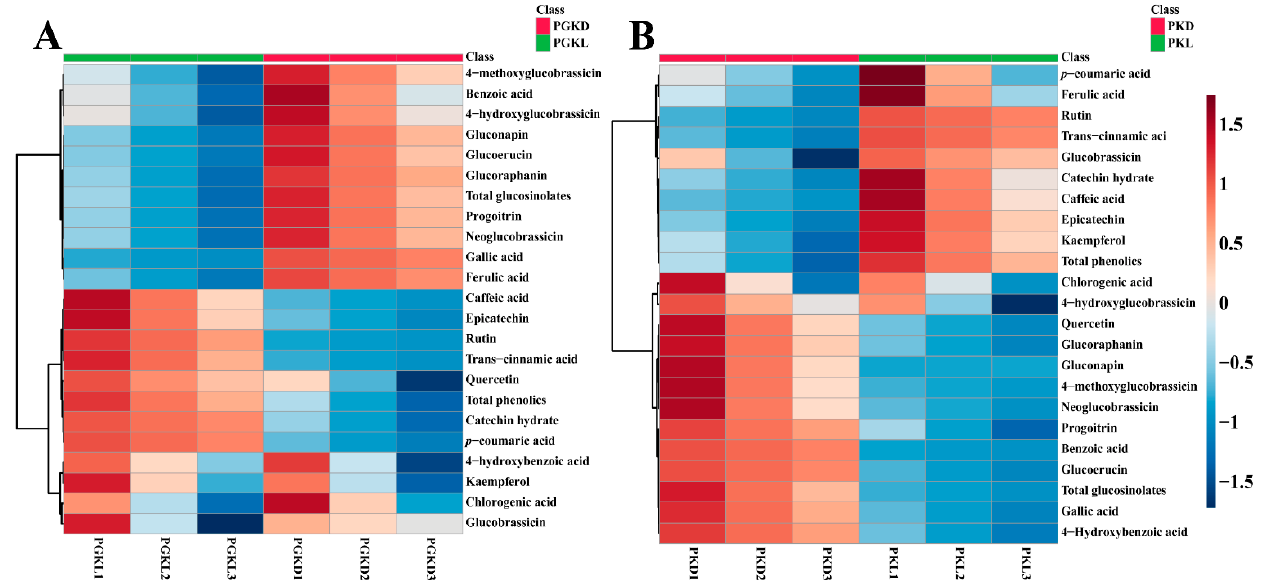
Figure 6. Heatmap ( A ) representing differences in the relative secondary metabolites concentration in the PGK cultivar grown under light and dark conditions, ( B ) representing differences in the relative secondary metabolites concentration in the PK cultivar grown under light and dark conditions.